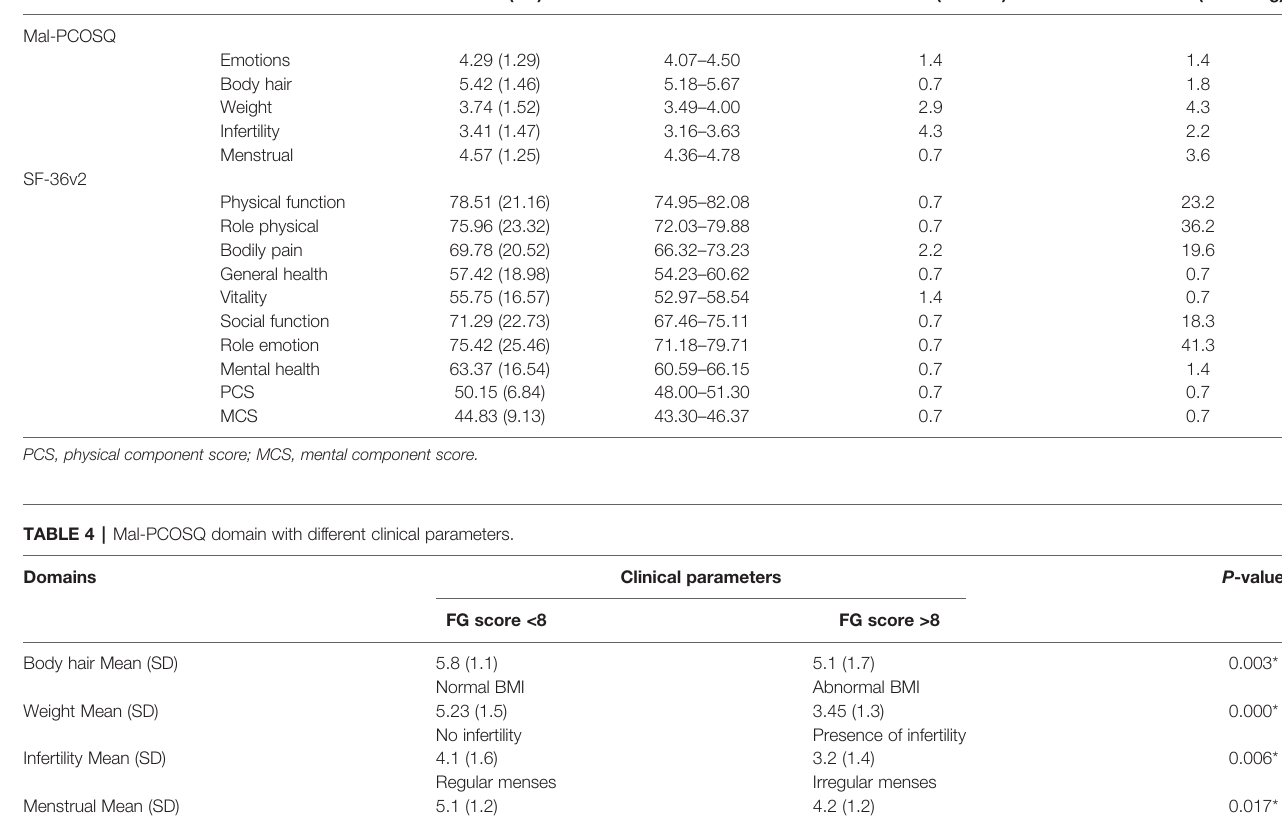
TABLE 3 | Mal-PCOSQ and SF-36 scores and fl oor and ceiling effects.